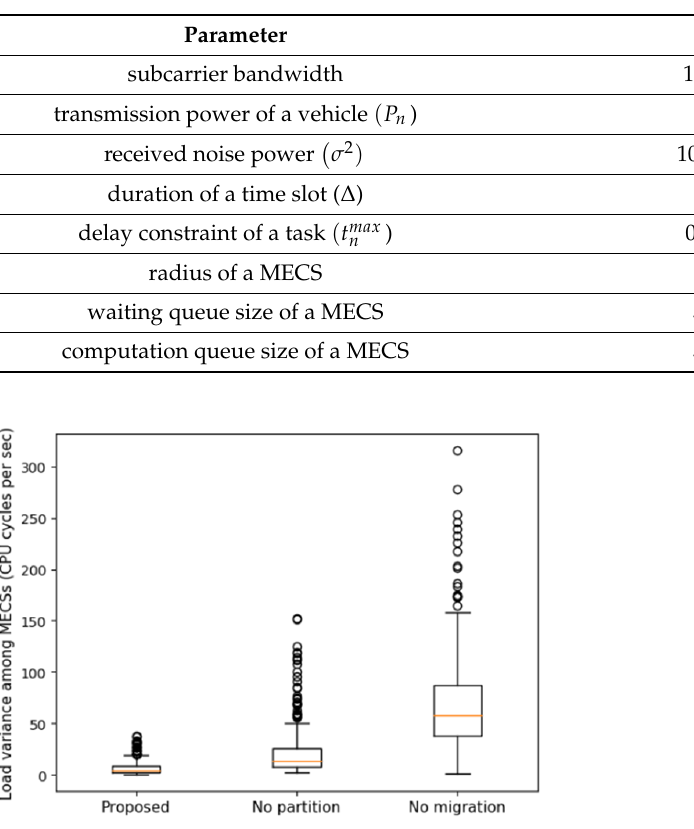
Table 1. Parameters used in the simulation.